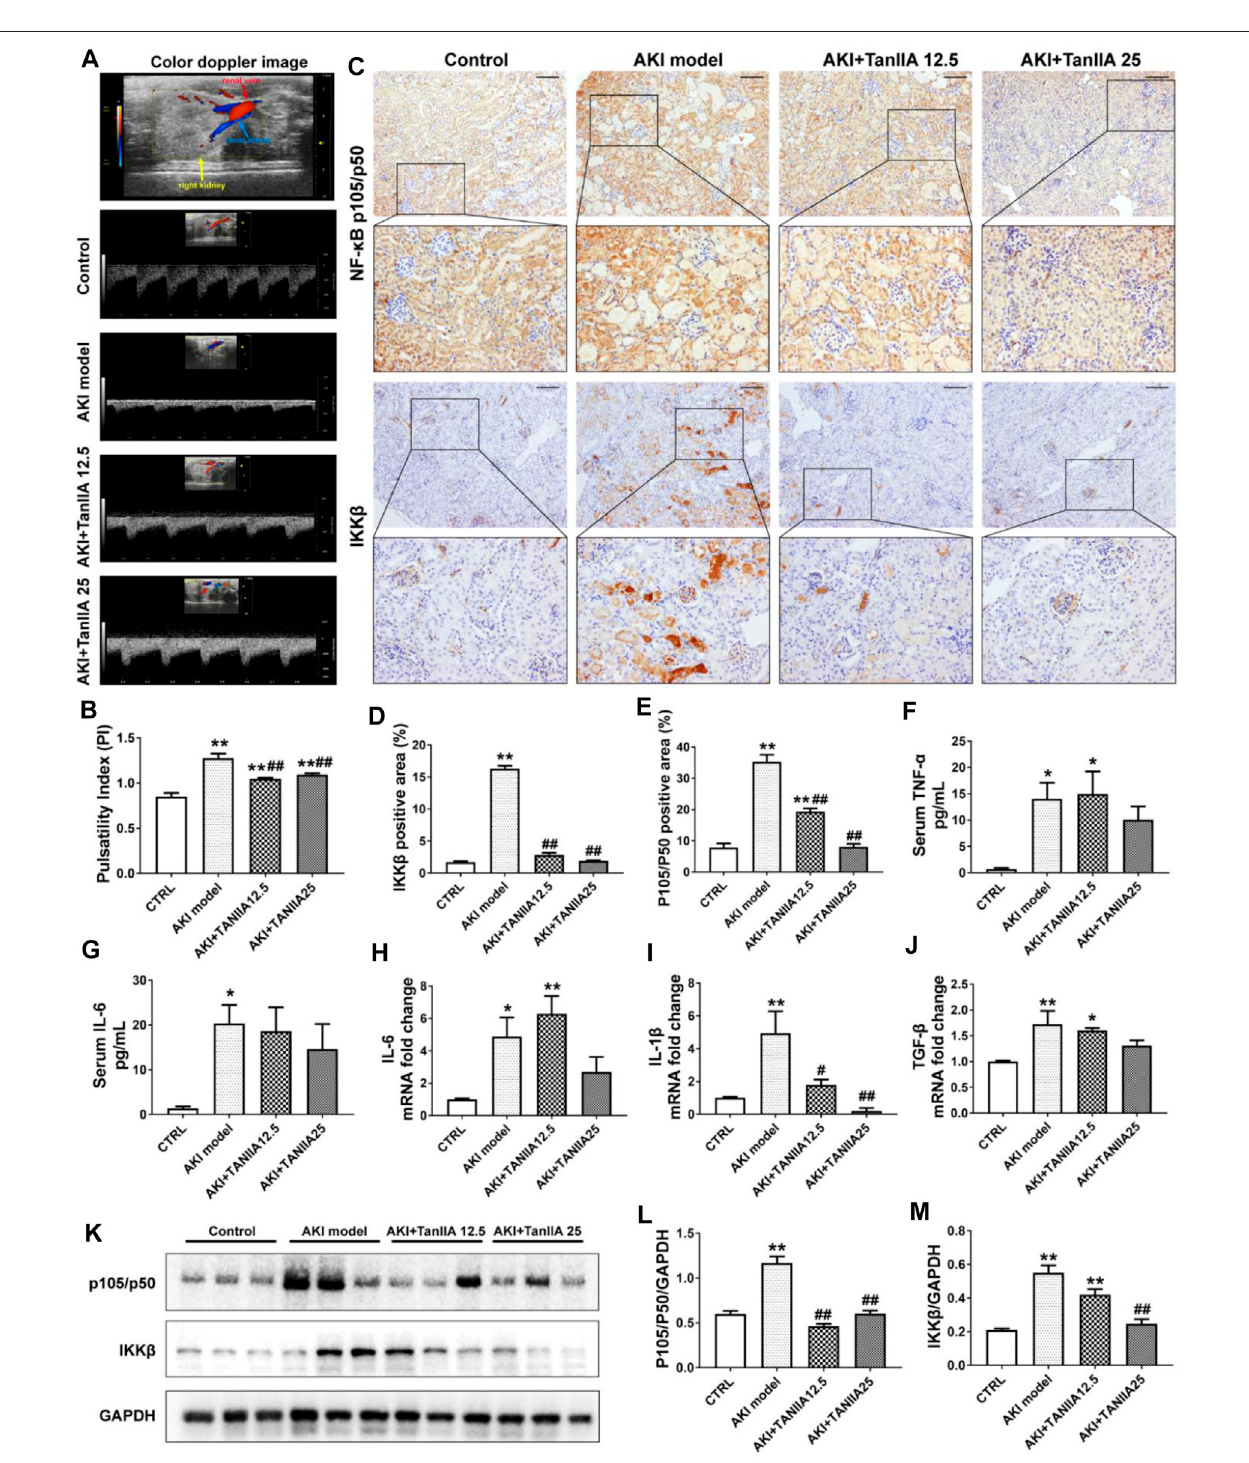
FIGURE 4 | TanIIA improves renal artery blood fl ow, reduces pro-in fl ammatory cytokine production, and inhibits the activation of NF- κ B signaling. (A,B) Representative image of renal vasculature with color Doppler in a mouse kidney (right) and representative bar chart of pulsatility index (PI) in mice. (C – E) Immunohistochemical staining of NF- κ B p105/p50 and IKK β and relative quantitative data in indicated groups; (F,G) ELISA bar chart representing serum level of TNF- α and IL-6. (H – J) mRNA level of IL-6, IL-1 β , and TGF- β in the kidney; (K – M) Protein expression and relative quantitative data of NF- κ B p105/p50 and IKK β . Data represent as mean ± SEM, *p < 0.05, **p < 0.01 compared with the control group ( n = 5). #p < 0.05, ##p < 0.01 compared with AKI group ( n = 5). One-way ANOVA followed by Turkey ’ s test for multiple comparisons was used for three or more groups. Scale bar, 50 μ m; abbreviations: IKK β , inhibitor of kappa B kinase beta; TNF- α , tumor necrosis factor-alpha; IL-6, interleukin-6; IL-1 β , interleukin-1 β ; TGF- β , transforming growth factor- β .